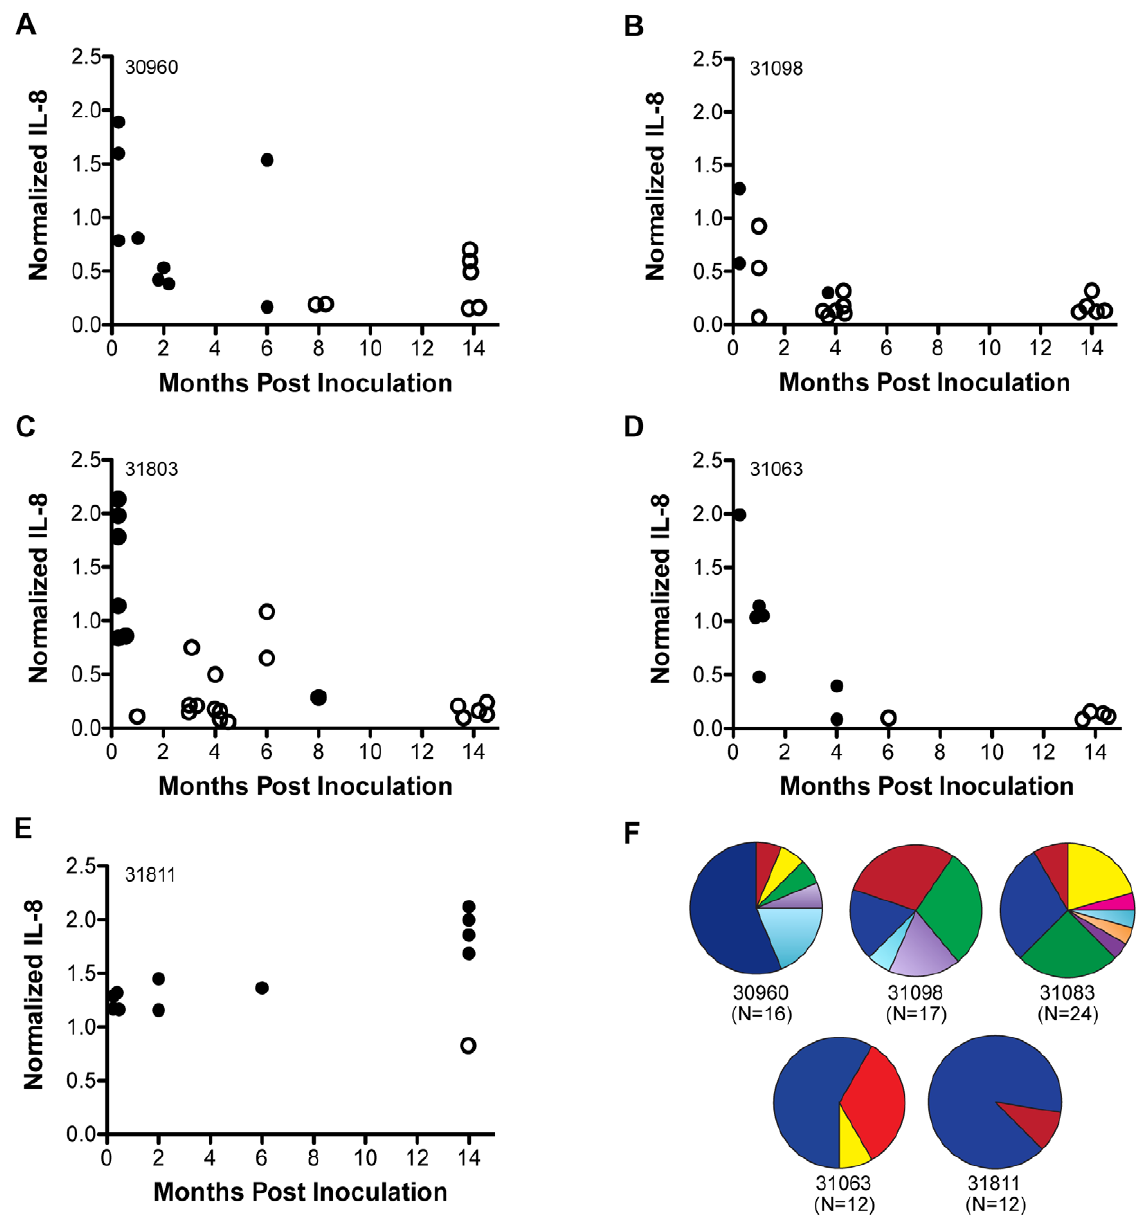
Figure 1. Loss of the capacity to induce IL-8 in H.pylori recovered from rhesus monkeys is associated with changes in the gene encoding CagY, an essential protein in the T4SS. (A–E) H. pylori was isolated from five rhesus macaques up to 14 months after experimental infection with H. pylori WT J166. Individual colonies were co-cultured with AGS cells, and ELISA was used to measure IL-8 levels, which were normalized to the WT J166 positive control. Each data point represents the results from a single colony. The capacity to induce IL-8 decreased over time in colonies recovered from four monkeys (A–D), but was largely unchanged in one (E). PCR-RFLP analysis showed that H. pylori colonies that lost the capacity to induce IL-8 were associated with a change in cagY (open circles), while those that maintained IL-8 induction typically had cagY that was indistinguishable from WT J166 (filled circles). Animal designation is shown in the upper left corner of each panel. (F) Output strains from each monkey were analyzed by cagY PCR-RFLP and compared to WT H. pylori J166 (dark blue) and to one another. Each pie chart represents all colonies recovered from one of the five monkeys (12–24 colonies/monkey); different colors represent different cagY variants.